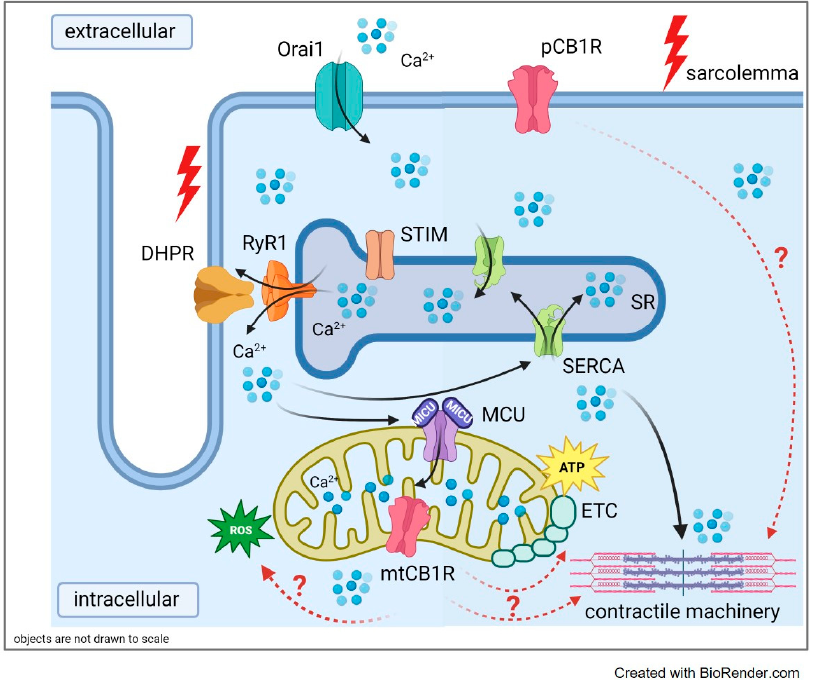
Figure 8. Summary of the proposed mechanism underlying hindered skeletal muscle function and ultrastructure by CB1 down-regulation. The arrows (black) indicate the path of calcium ions upon release from the sarcoplasmic reticulum (SR). Red arrows tackle the connection between the under- lined players. Genetic ablation of CB1R leads to impaired contractility and altered mitochondrial morphology. Legend: pCB1R: plasma membrane cannabinoid receptor 1; mtCB1R: mitochondrial cannabinoid receptor 1; MCU (MICU1): mitochondrial calcium uniporter complex; ETC: electron transport chain; RyR1: ryanodine receptor type 1; DHPR: dihydropiridine receptor, STIM: stromal interaction molecule, Orai1: calcium release-activated channel 1; SERCA: sarco(endo)plasmic reticulum calcium pump; ROS: reactive oxygen species.